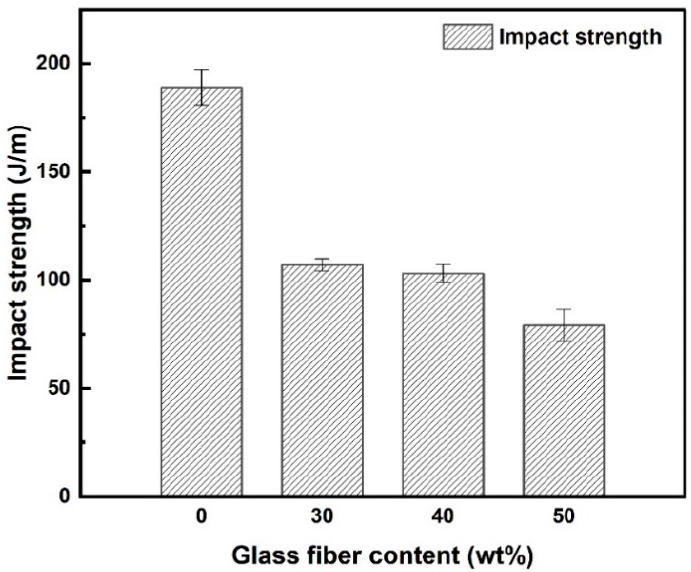
Figure 4. Effect of GF content on flexural strength and modulus of GF/mPPO composites.